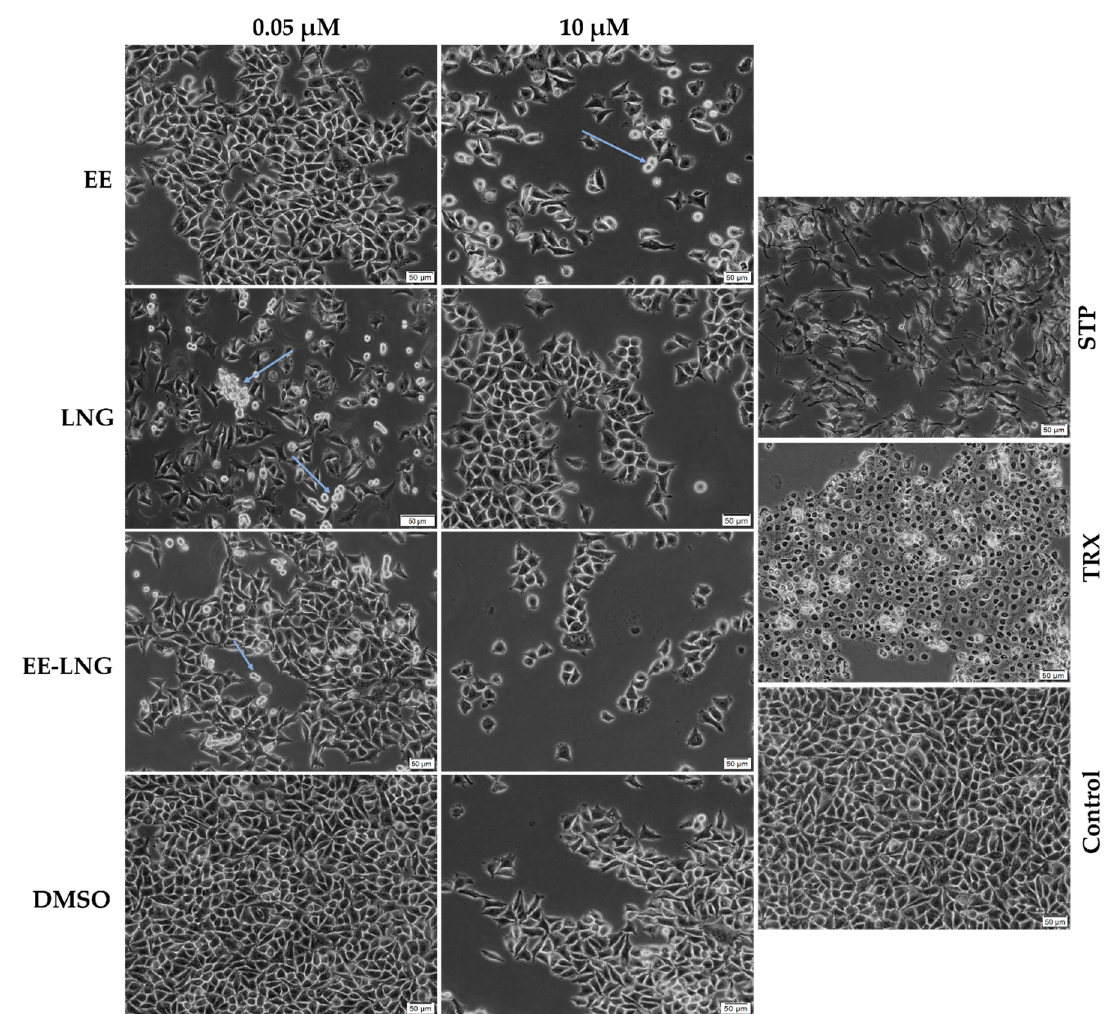
Figure 2. Morphological aspect of the MDA-MB-231 cells after the treatment with EE, LNG, EE-LNG, and DMSO (0.05 and 10 µM) solutions for 24 h. The arrows indicate the round and detached cells noticed following the treatment with OCs. The morphological changes induced by Staurosporine (STP) 5 µM selected as an indicator for apoptosis and Triton X-100 (TRX) 0.5% used as an indicator for necrosis are presented as well. The pictures were taken 24 h post-treatment. The scale bars represent 50 µm.